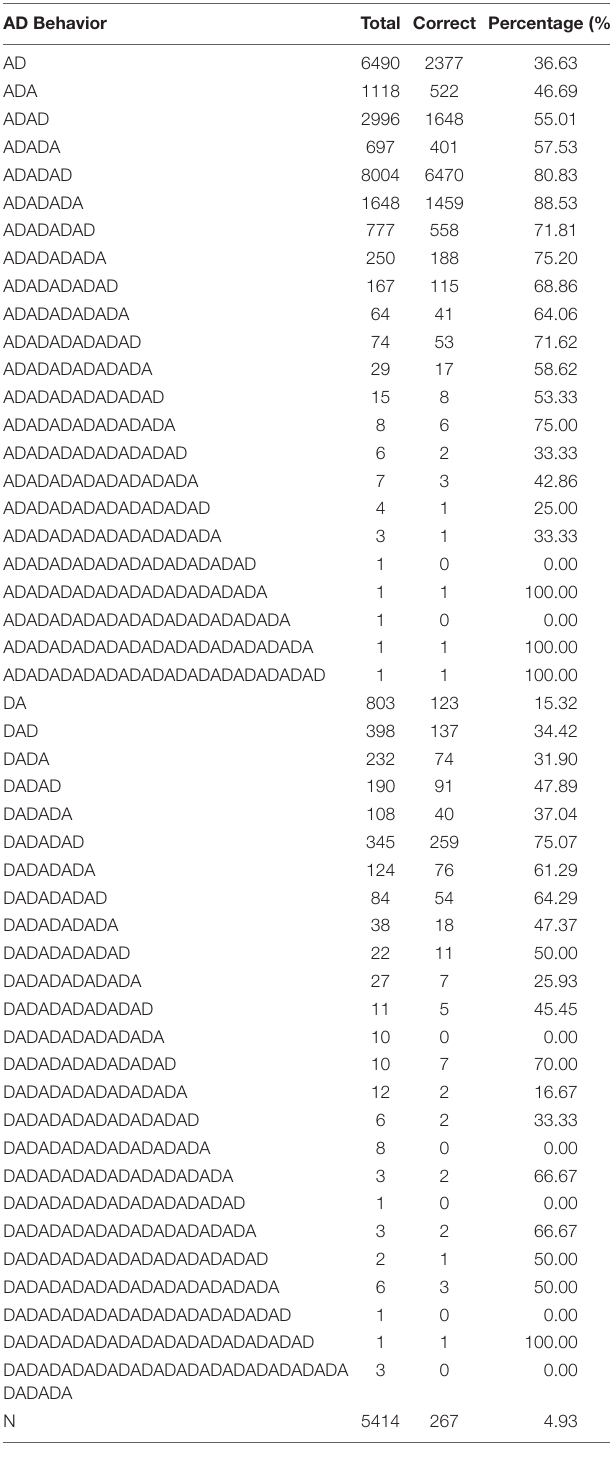
TABLE 3 | All levels of AD sequence with sample size and percentage of correctness.